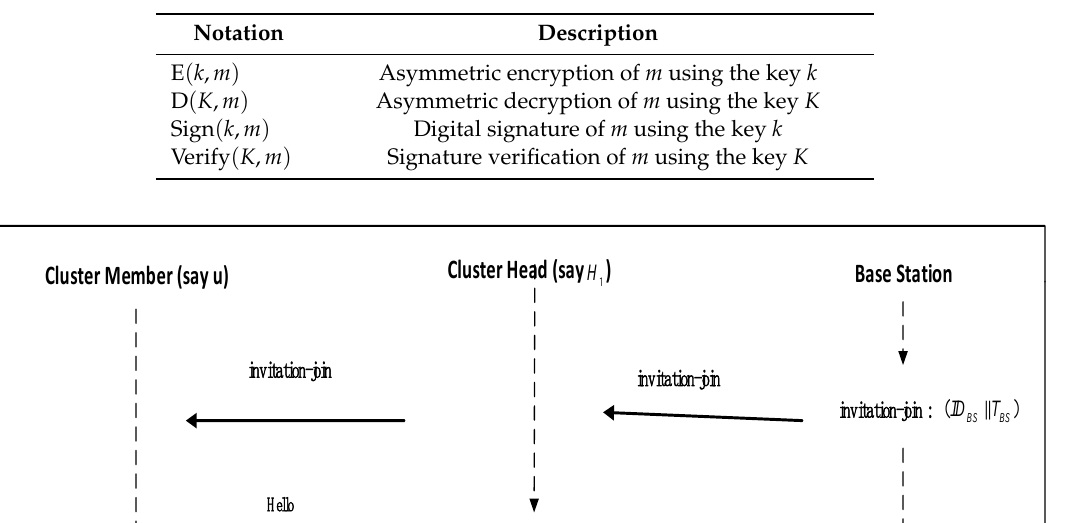
Table 1. Notation for security protocols.